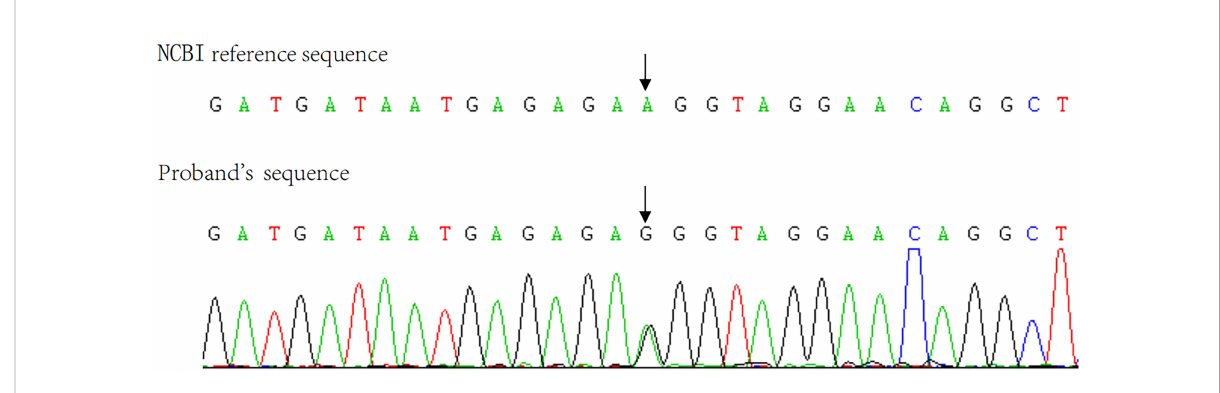
FIGURE 2 Sanger sequencing showed the patient ’ s C.439 A>G mutation in exon 4 of the PRKAR1A